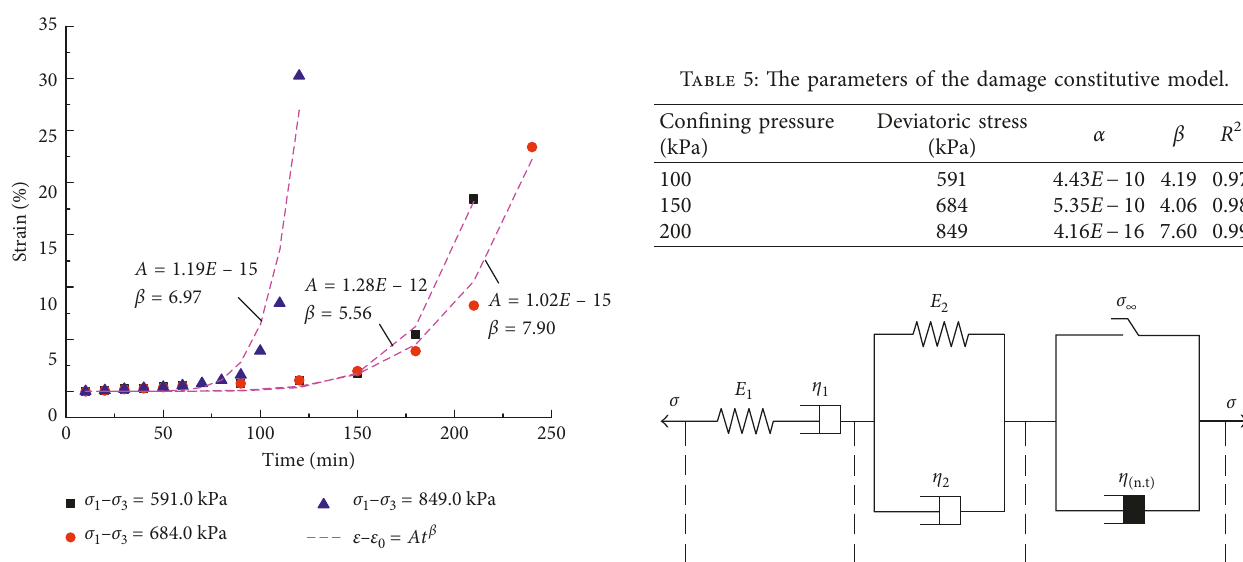
Figure 8: Relationship between the exponential equation fitting curves and test curves.